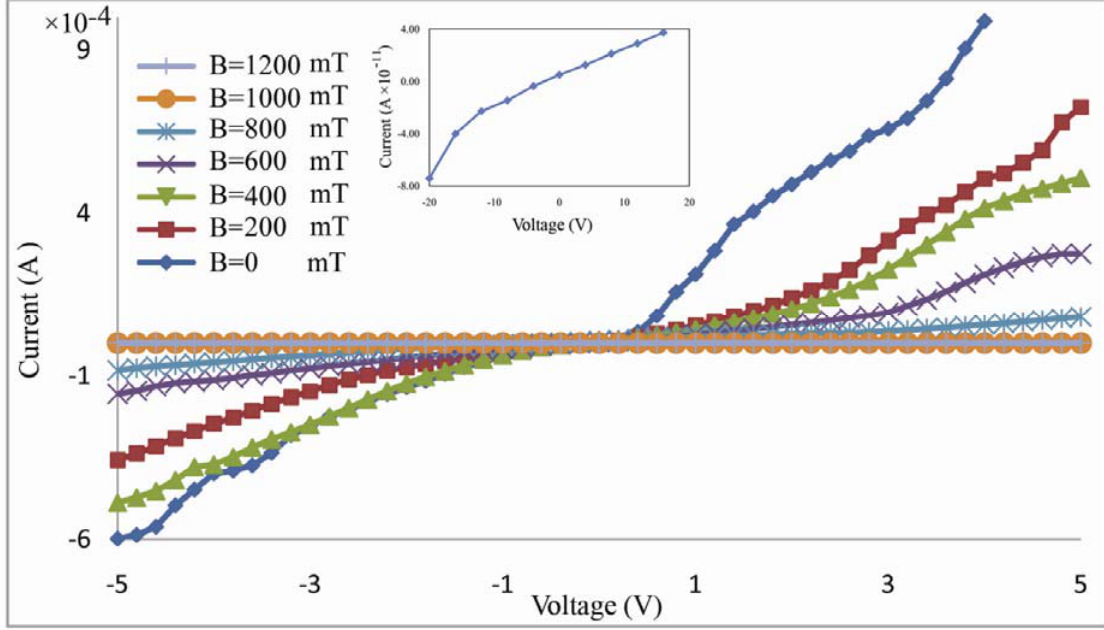
Figure 3. The I-V curve for gold-DNA-gold structure in presence of various magnetic fields at room temperature. The subfigure shows I-V curve of the junction between the two electrodes in absence of DNA molecules.